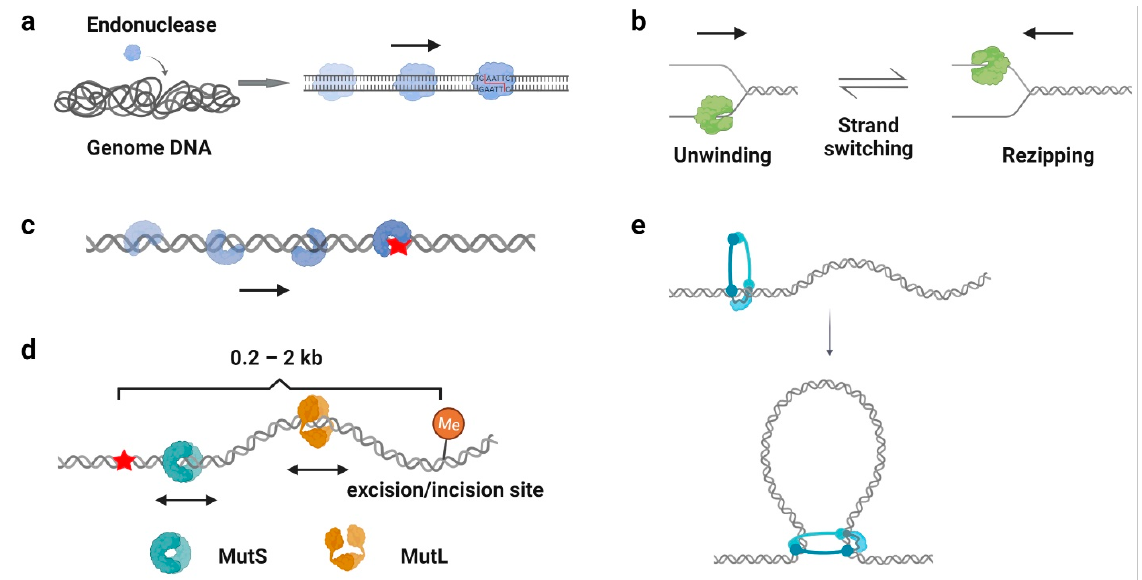
Figure 3. Biological functions of protein 1D sliding. ( a ) An illustration showing the process of an endonuclease targeting a sequence-specific site among the genome by facilitated diffusion. Arrows indicate the sliding of an endonuclease to a target site. ( b ) An illustration showing a helicase unwinding and rezipping on DNA. Black arrows indicate the directions of helicase translocation. ( c ) An illustration showing a DNA repair protein scanning along the DNA backbone and recognizing a damage site (red star). ( d ) An illustration showing the distant communications between a mismatch (red star) and an excision/incision site via MutS and MutL sliding clamps. Arrows indicate the sliding of MutS and MutL. ( e ) An illustration showing condensin binding to the DNA and extruding it as a loop to spatially organize the chromosomes.